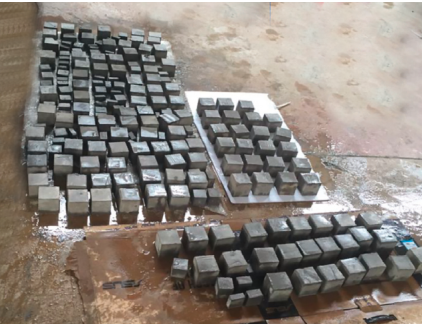
Figure 7: Cement bricks with the size of 70mm